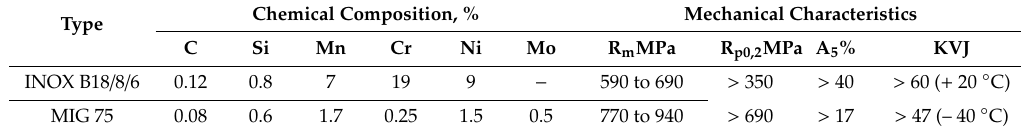
Table 3. Chemical composition and mechanical characteristics of used filler materials